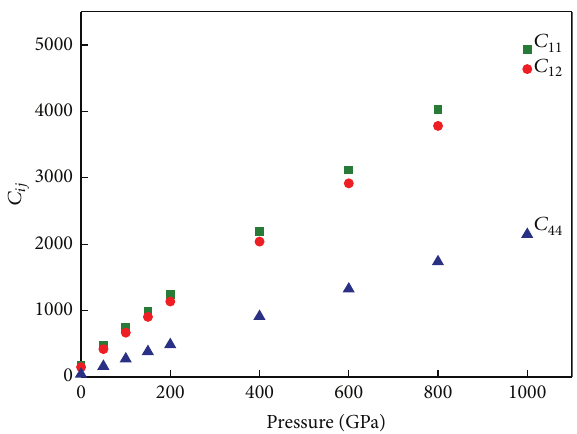
Figure 3: Typical cubic elastic constants of Au from 0GPa to 1000 GPa.